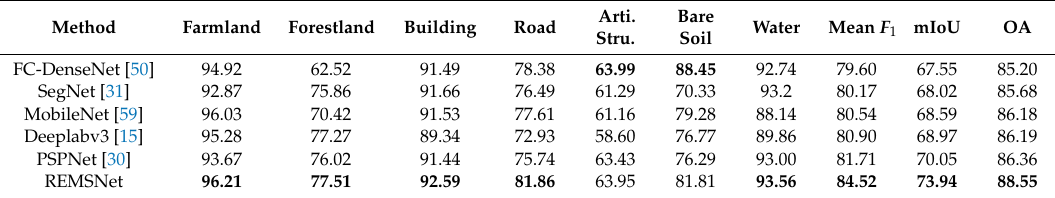
Table 2. Experimental land cover classification results on the Shanghai dataset (%). The largest land cover classification accuracy is highlighted in